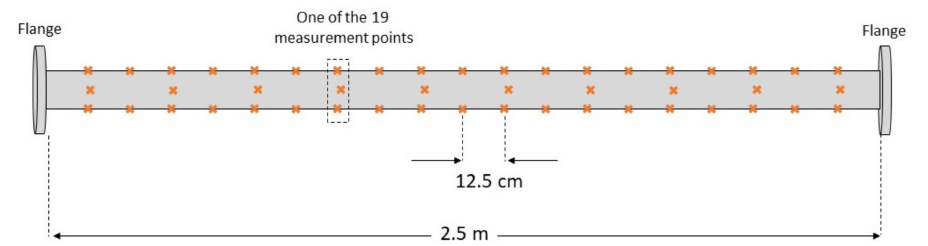
Figure 4. Side view of the thermocouple